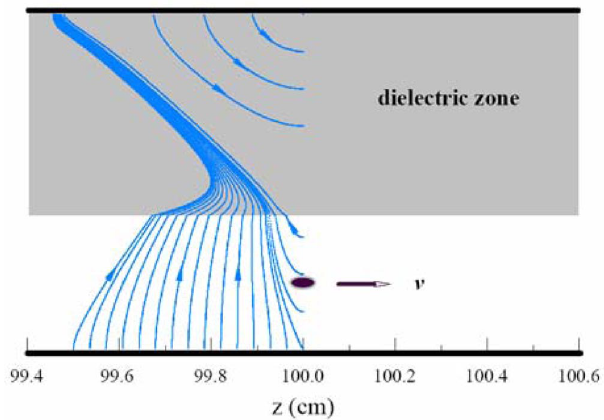
FIG. 10. (Color) Electric field force lines for 400 propagating modes around a moving point bunch in a DLW structure. Parameters for the structure and the bunch are given in Fig. 9. It is seen that there is no field in front of the bunch, and some force lines stop on the plane where the bunch is located, but not on the bunch.